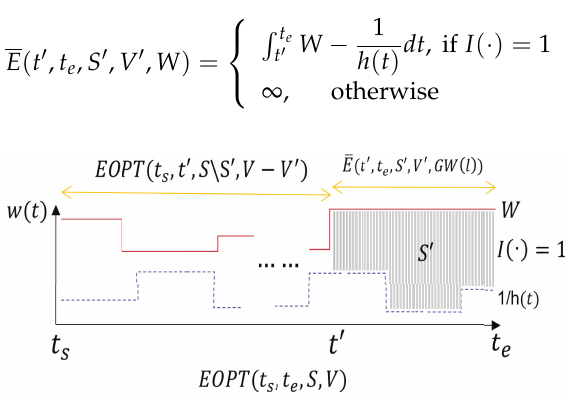
Figure 4. An example showing the recursive function of EOPT ( · )